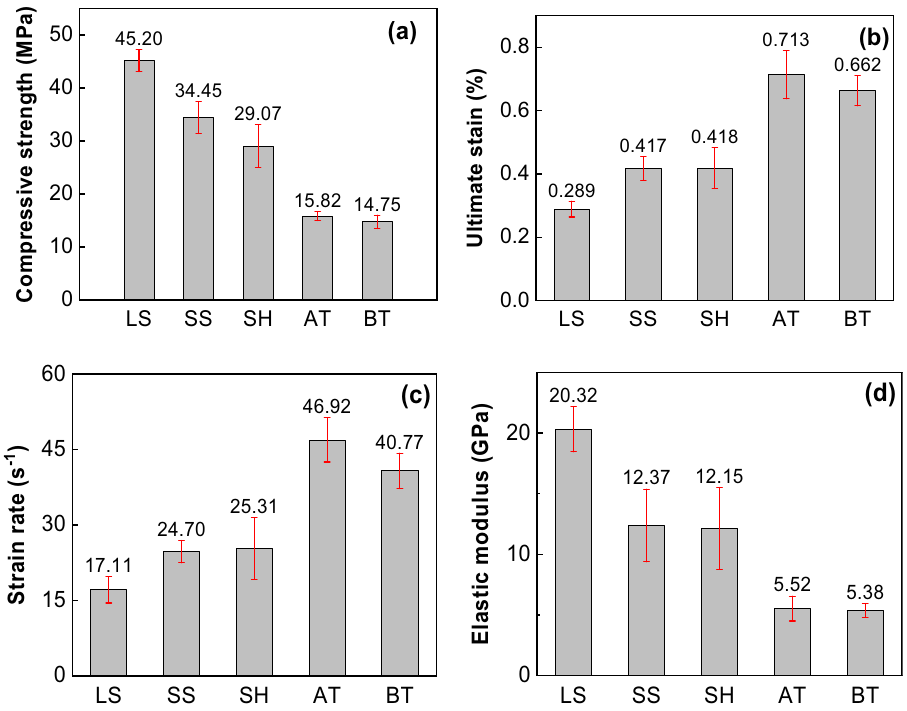
Figure 8. Dynamic mechanical parameters of different types of specimens. ( a ) Compressive strength, ( b ) ultimate strain, ( c ) strain rate, ( d ) elastic